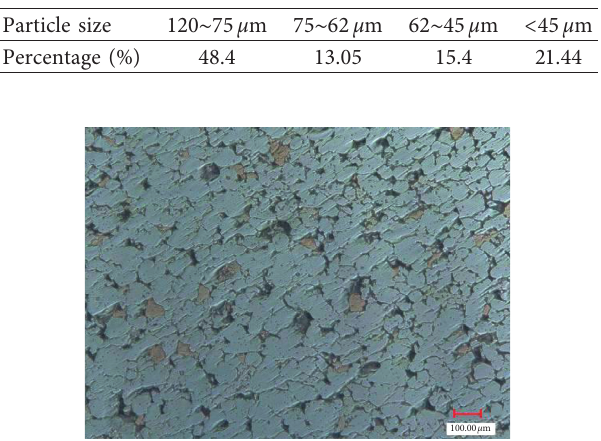
Figure 1: Microstructure of the green compacts.